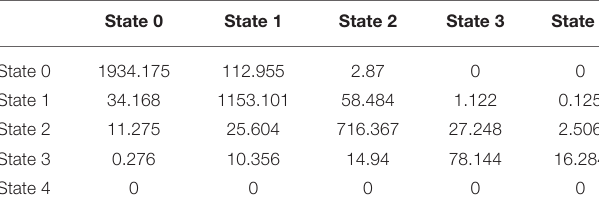
TABLE 9 | The expected transition counts after one year of the